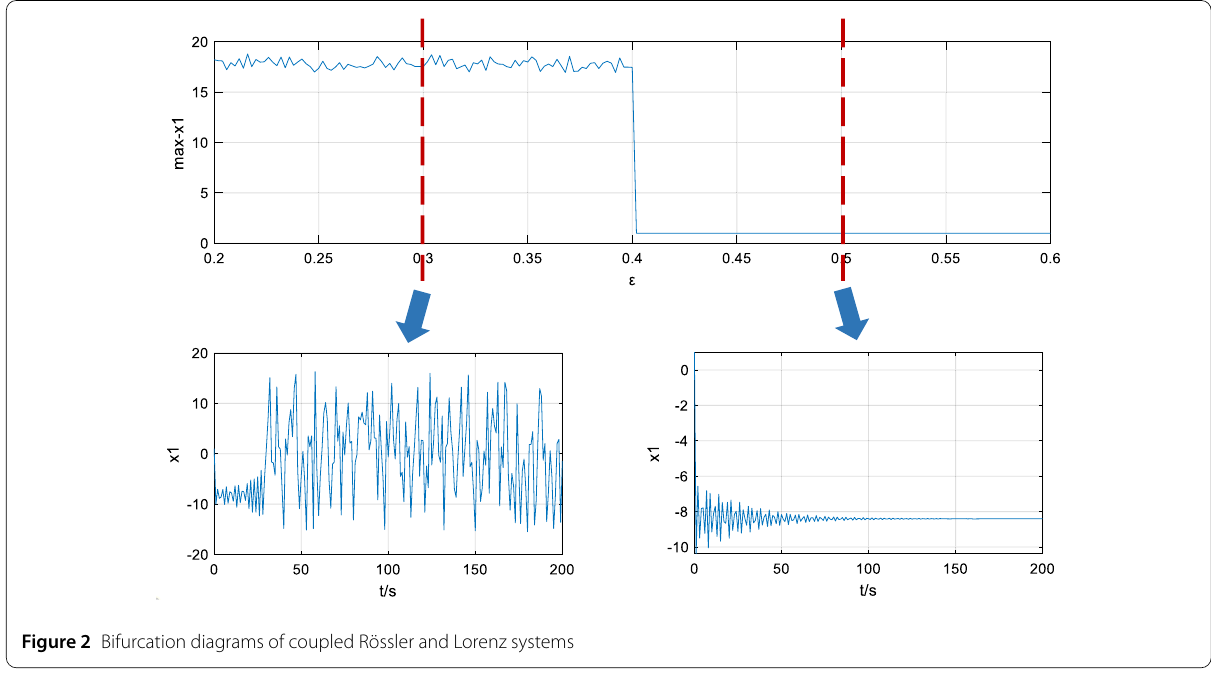
Figure 2 Bifurcation diagrams of coupled Rössler and Lorenz systems